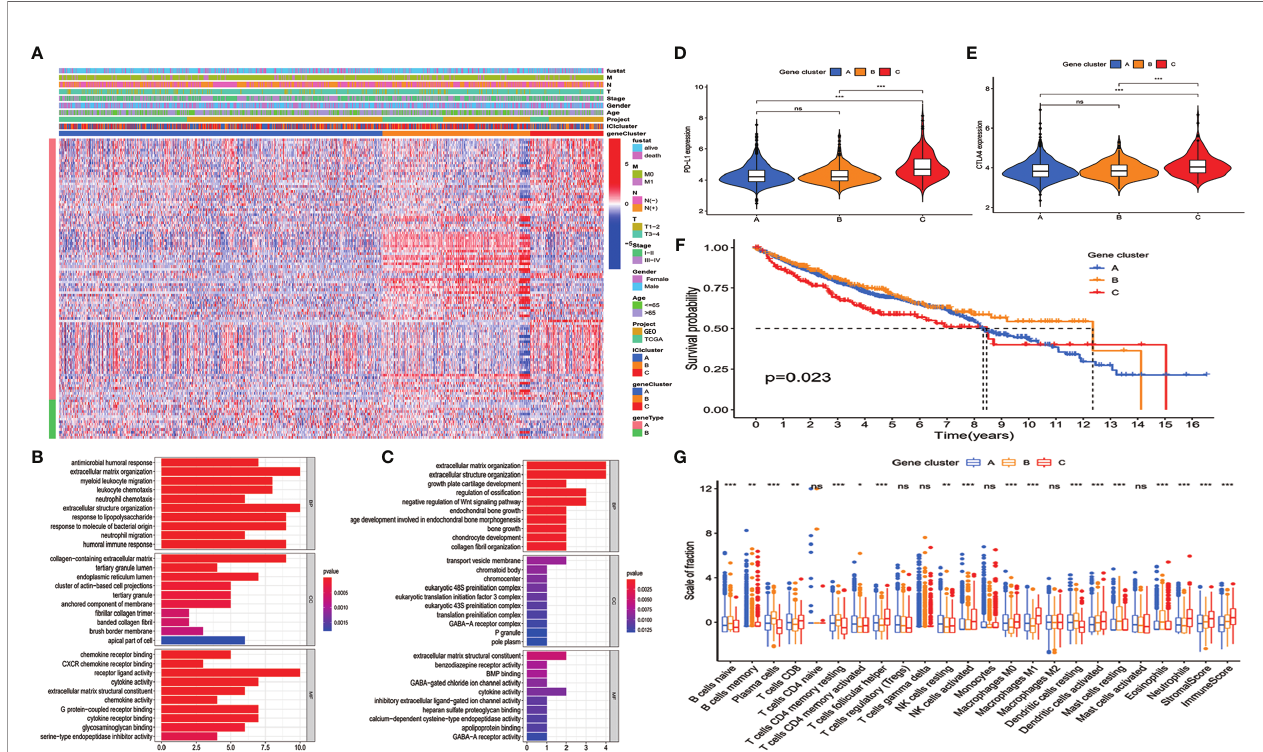
FIGURE 2 | Clustering of immunogenic gene. (A) An unsupervised clustering of the differentially expressed genes was used to classify colon cancer patients into three gene clusters: gene cluster A, gene cluster B, and gene cluster C. (B, C) Enriched biological processes in immune cell in fi ltration (ICI) signature A (B) ( p < 0.05) and signature B (C) ( p < 0.05). (D) PD-L1 and (E) CTLA4 expressions in the three gene clusters (Kruskal – Wallis test, *** p < 0.001). (F) Overall survival for patients in the three gene clusters (the log-rank test, p = 0.023). (G) The proportion of immune cells in three gene clusters. The immune score and stromal score of three ICI clusters were also plotted (mean ± SD, Kruskal – Wallis test. * p < 0.05; ** p < 0.01; *** p < 0.001; ns, non signi fi